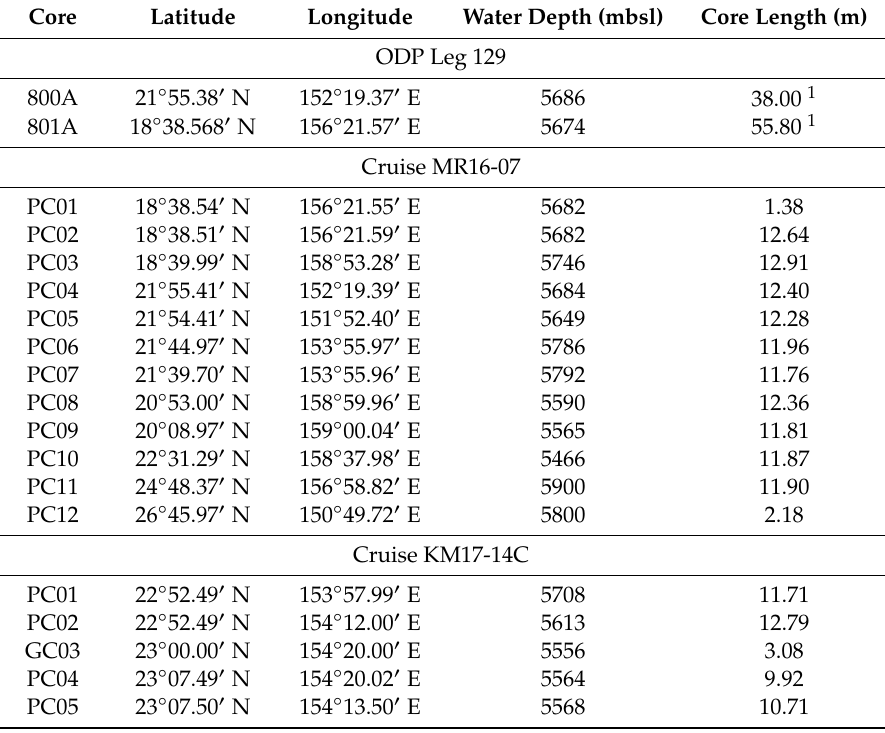
Table 1. Locations of the sediment cores collected by the Ocean Drilling Program (ODP) Leg 129, Cruises MR16-07, and